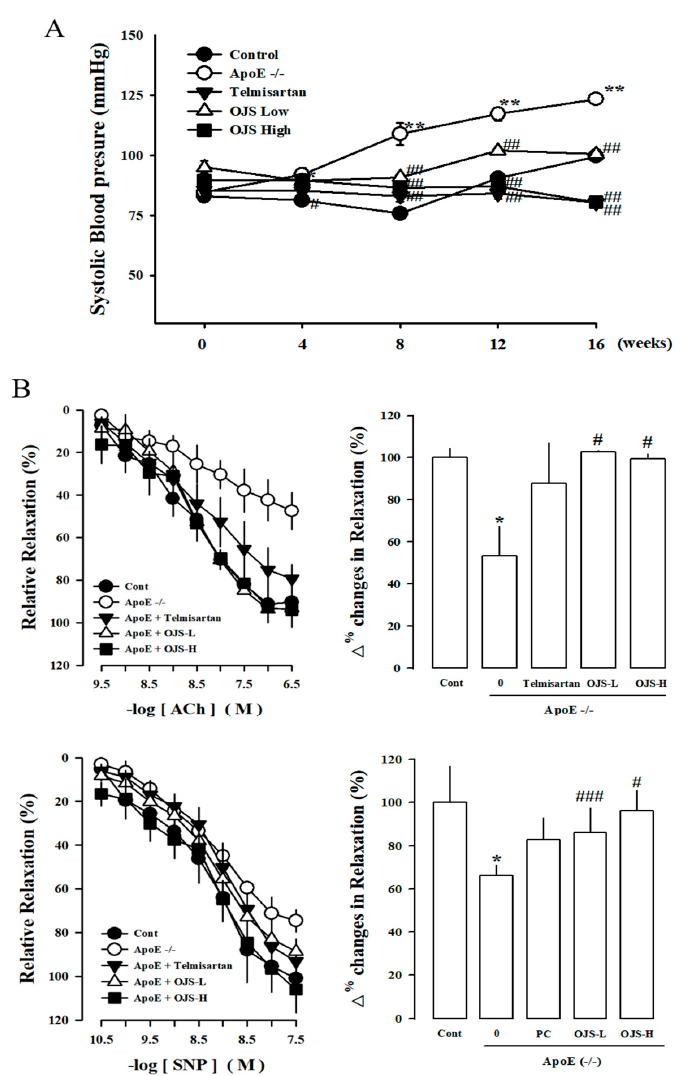
Figure 2. Effect of OJS on vasodilation in Apolipoprotein-E gene knockout (ApoE − / − ) mice. The effect of OJS on systolic blood pressure in ApoE − / − mice ( A ). Cumulative concentration–response curves to acetylcholine (ACh) and the endothelium-dependent vasodilator, sodiumnitroprusside (SNP), in the arteries from experiment mice ( B ). PC, positive control; Values are expressed as mean ± S.E. (Standard Error) ( n = 5). * p < 0.05, ** p < 0.01 vs. control group; # p < 0.05, ## p < 0.01, ### p < 0.001 vs. the ApoE − / − group.